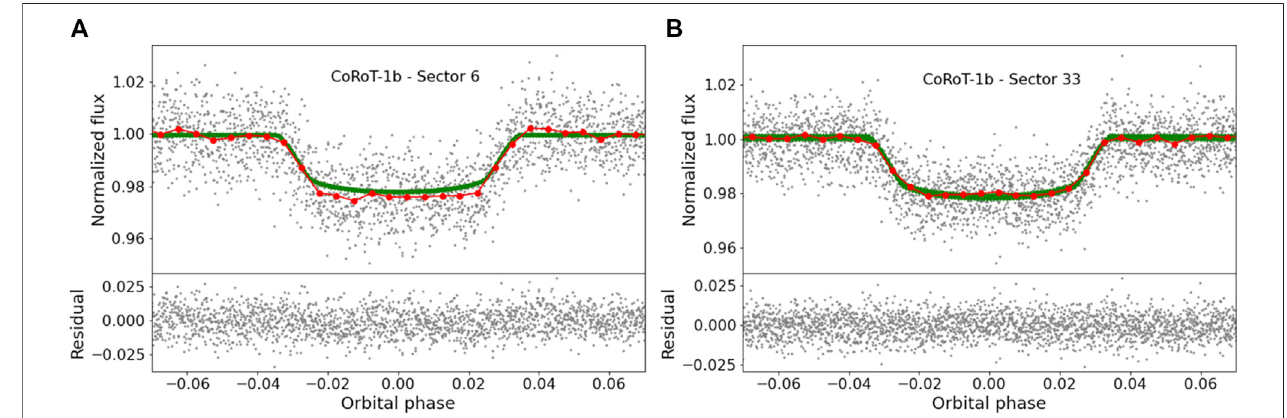
FIGURE 1 | Transit fi ts and residuals for the TESS short cadence phase folded light curves of the analyzed CoRoT planets. gray dots are the normalized PDCSAP fl uxvalues.Intheupperpanelofeachsub- fi gurethegreenlineshowsthetransit fi t(fordetaileddescriptionseeSection2.3).Thereddotsanderrorbarsrepresentbinned data and are only used for visualization purposes. The lower panels show the residual light curves after the fi